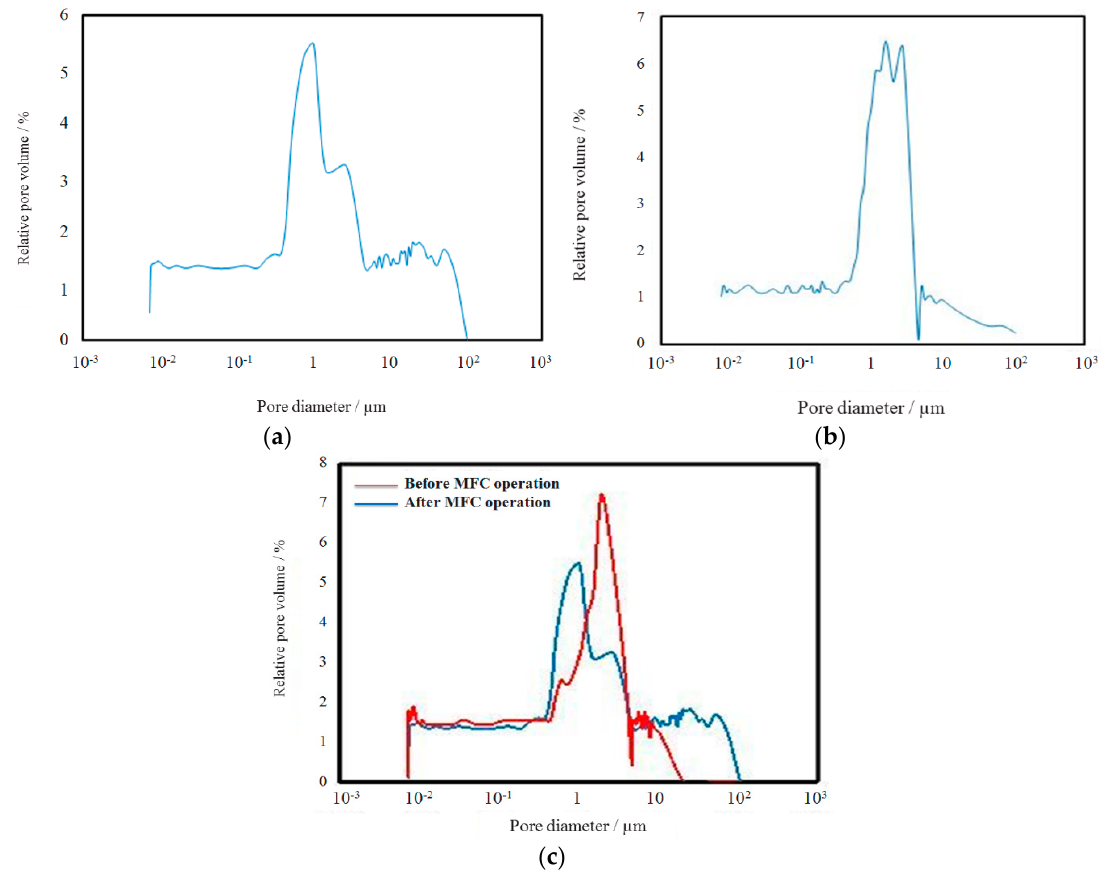
Figure 2. ( a ) Pore size distribution of a HGDL with composition FEP:PSf 75:25; ( b ) Pore size distribution of an AL/SS without HGDL (determined by Hg intrusion porometry); ( c ) Effect of MFC operation on pore size diameter.